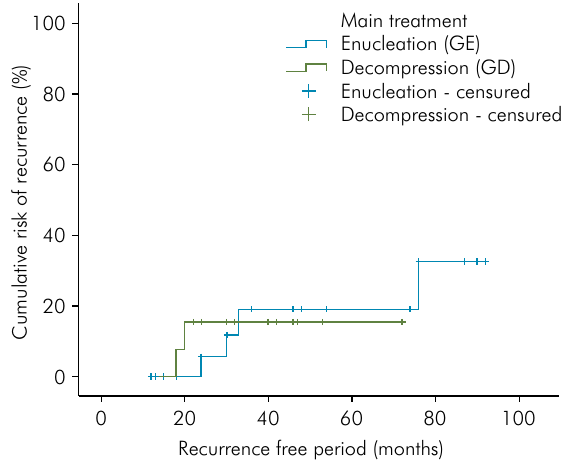
Figure 5. The cumulative risk of recurrence by the Kaplan-Meier analysis according to the main treatments.